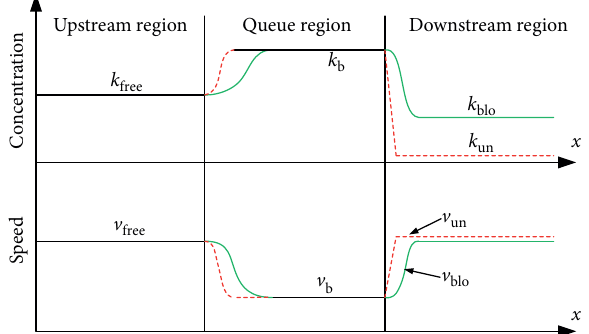
Figure 6: Schematic diagram of the traffic characteristics in moving